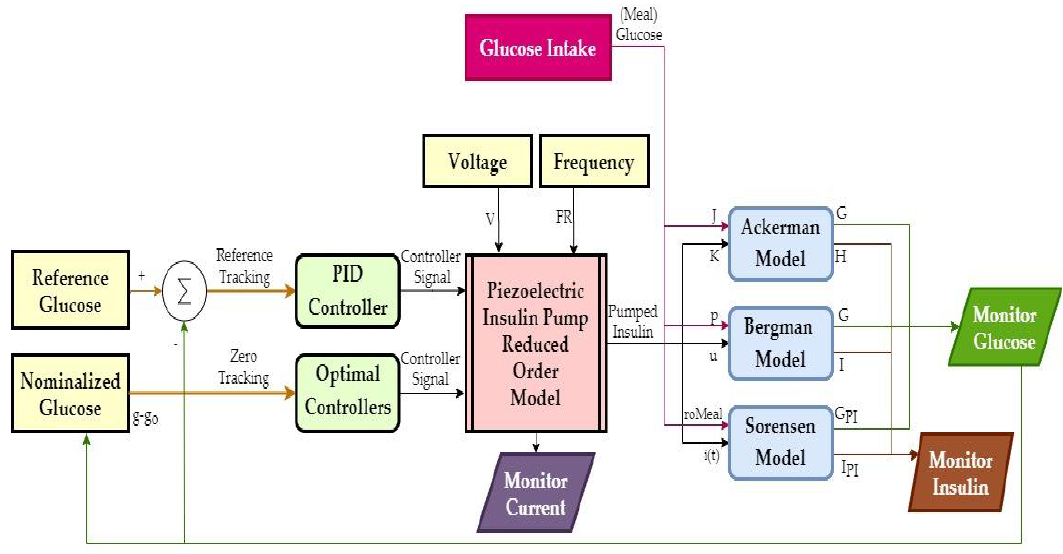
Figure 8. Overview of the closed-loop control simulations.